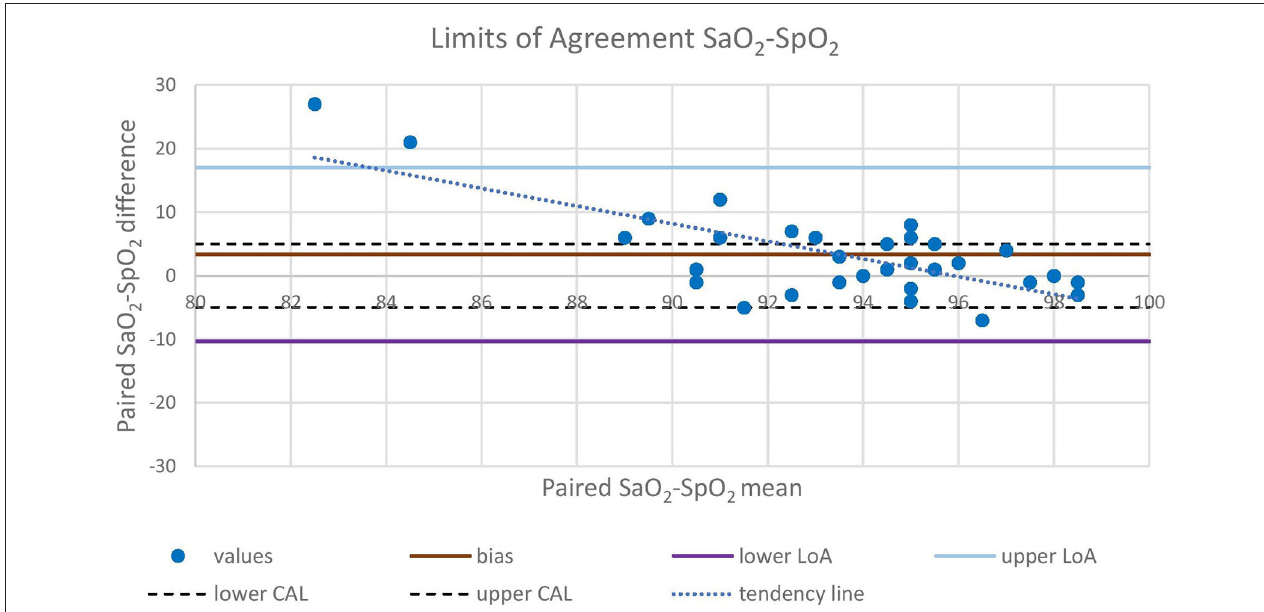
FIGURE 1 | Bland-Altman analysis plots the difference between concurrent SaO 2 and SpO 2 values (Y-axis) against the mean between concurrent SaO 2 and SpO 2 values (X-axis). Mean difference (bias), upper LoA (bias + 1.96 SD), and lower LoA (bias – 1.96 SD) between paired values are represented with straight lines. Upper CAL (5%) and lower CAL ( − 5%) are represented with dashed lines. LoA, Limit of Agreement; CAL, Clinically Acceptable Limit; SaO 2 , arterial oxyhemoglobin saturation; SpO 2 , peripheral oxyhemoglobin